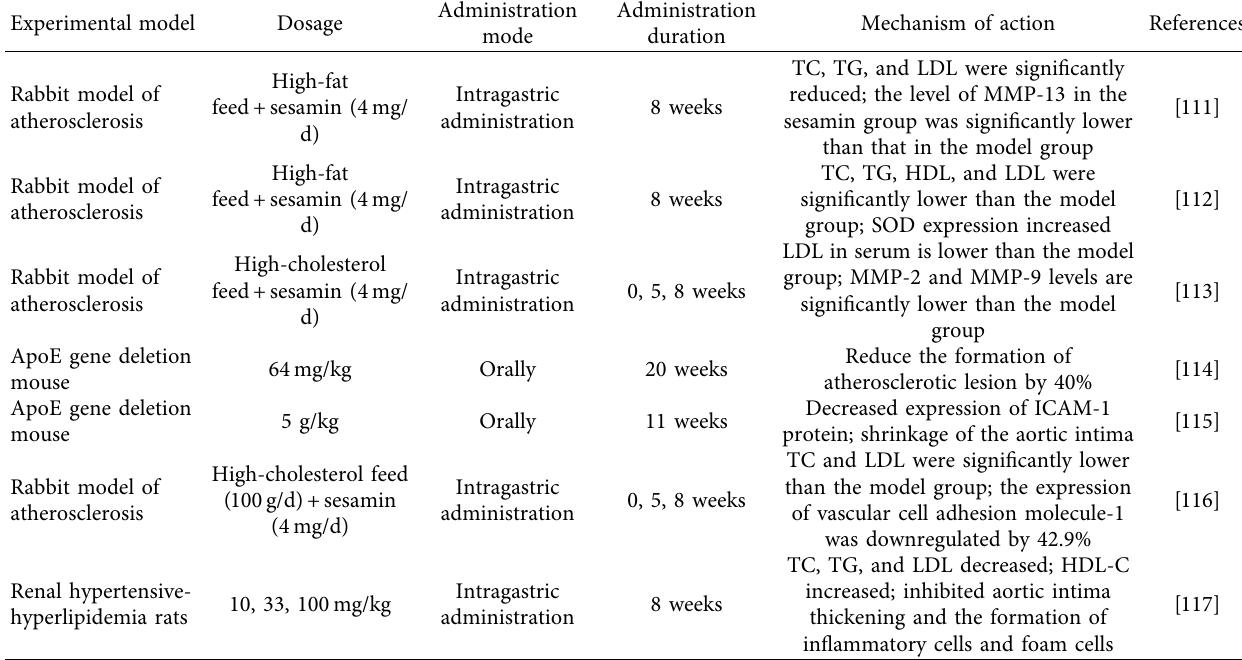
Table 6: Effects of sesamin on